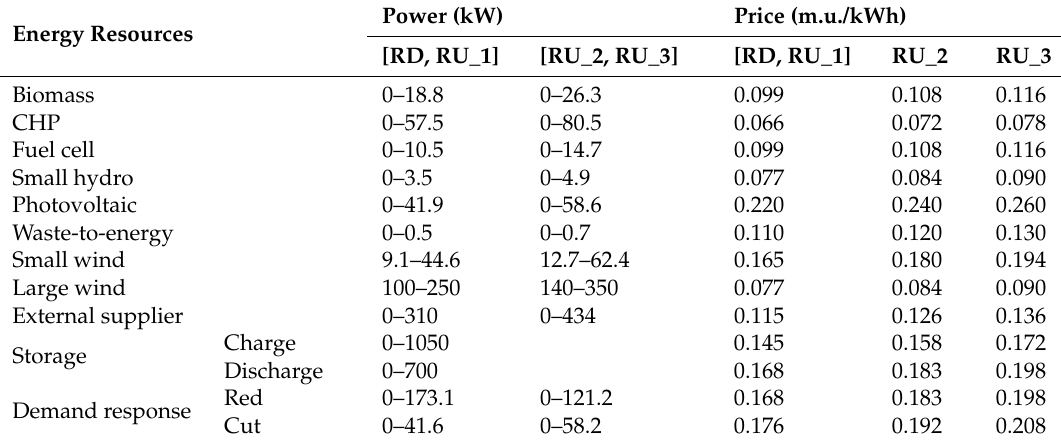
Table 2. Resources data for all reserve